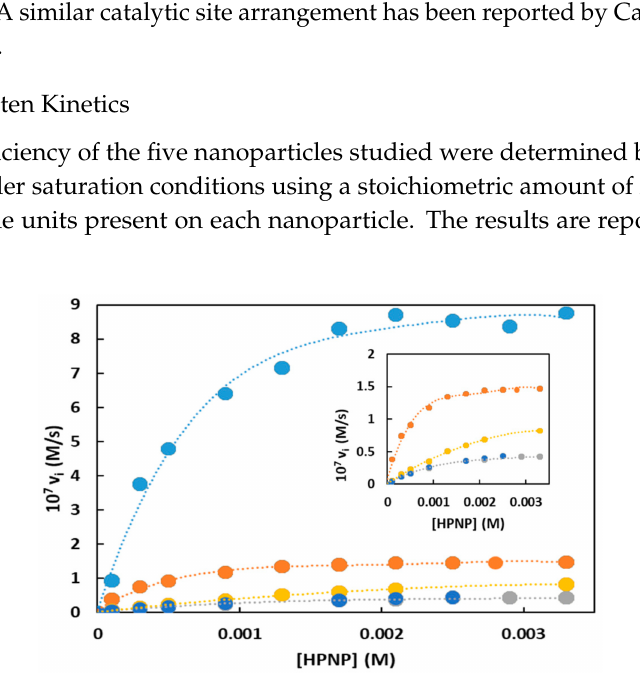
Figure 3. Michaelis–Menten kinetics obtained for the cleavage of HPNP by catalysts AuNP1-5. Conditions: [AuNP], (in triazacyclononane units) = [Zn(II)] = 2.5 × 10 − 5 M, [EPPS, bu ff er] = 1.0 × 10 − 2 M pH = 7.5, 25 ◦ C. Symbols code: AuNP1: Light blue; AuNP2: Orange; AuNP3: Gray; AuNP4: Yellow; AuNP5: Dark blue. Inset: Blown-up plot without the AuNP1 trace. Table 1. Kinetic parameters obtained from the Michaelis–Menten analysis of the cleavage of HPNP by catalysts